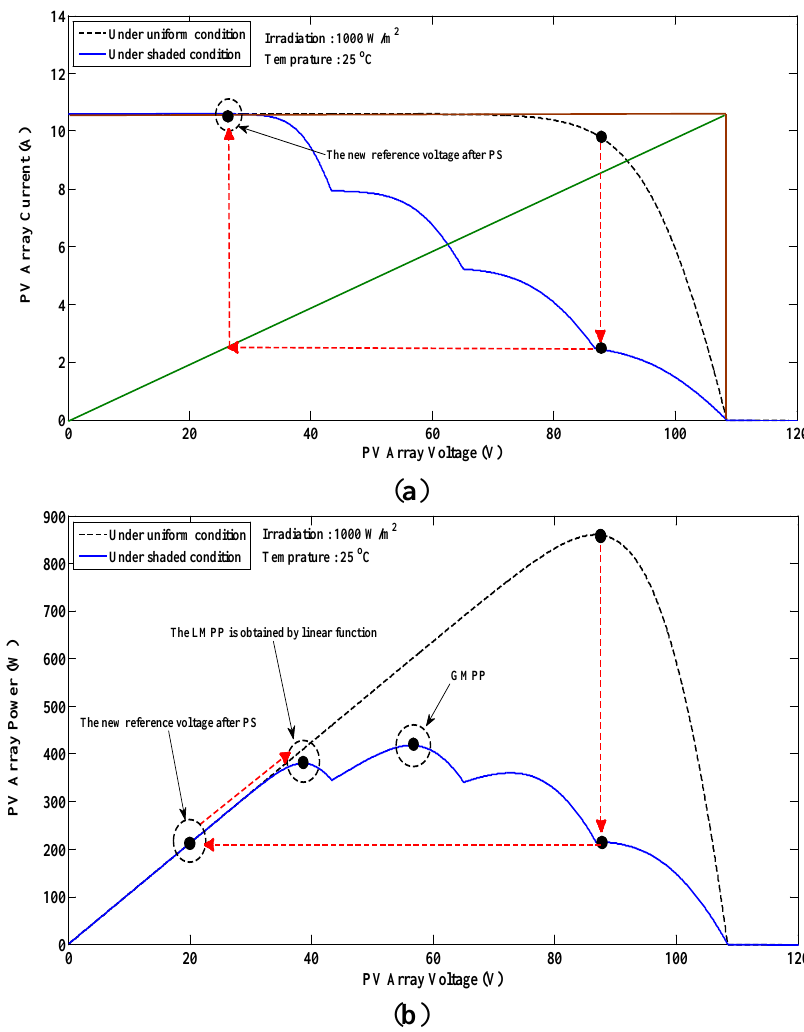
Figure 6. Tracking of the GMPP based on the linear function method for the second case of the complicated scenario ( a ) I-V curve and ( b ) P-V